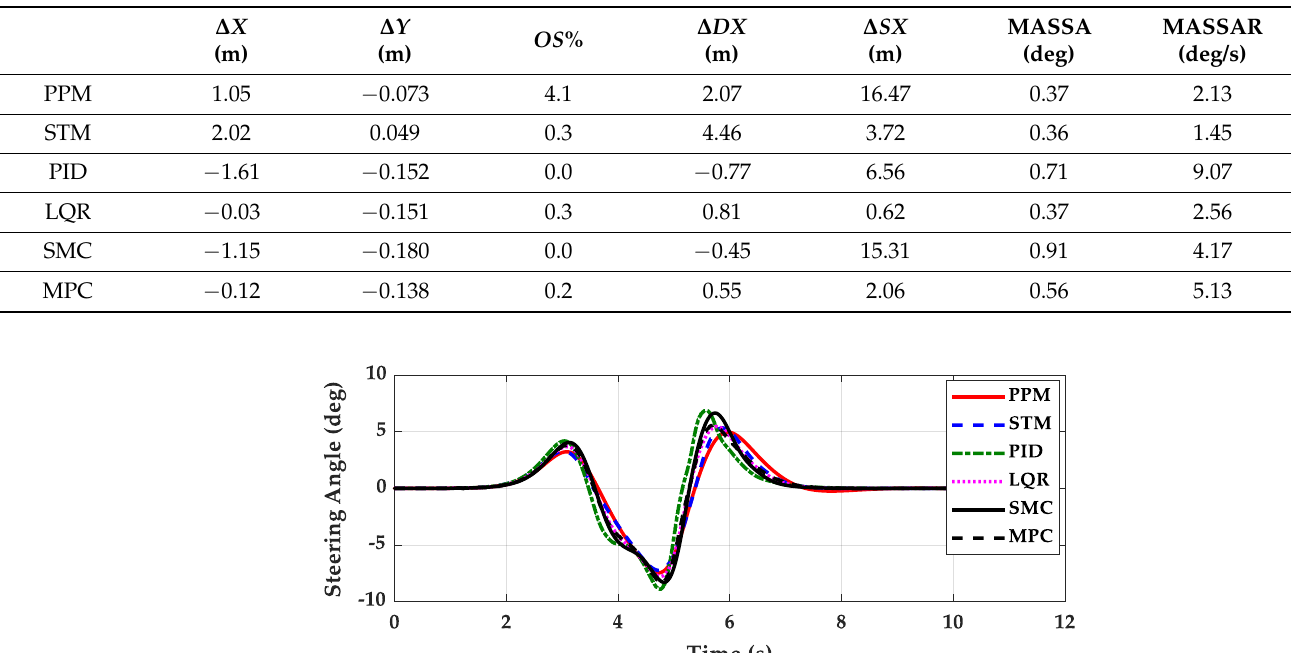
Table 9. Summary of simulation results of each controller for 4WS vehicle in the fourth set of simulations.